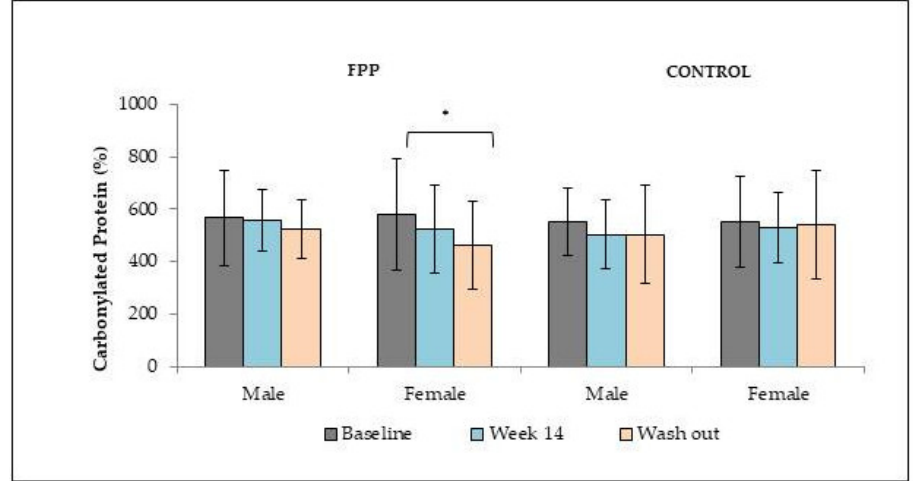
Figure 2. The effect of fermented papaya preparation (FPP) on carbonyl protein accumulation as a percentage compared to control (1% NaCl) in a pre-diabetic population under the FPP ( N = 41) and control regimes ( N = 58); error bars represent standard deviation. * p < 0.05 vs. baseline. Reproduced with permission from Somanah et al. [31], Food and Chemical Toxicology; published by Elsevier, 2014.